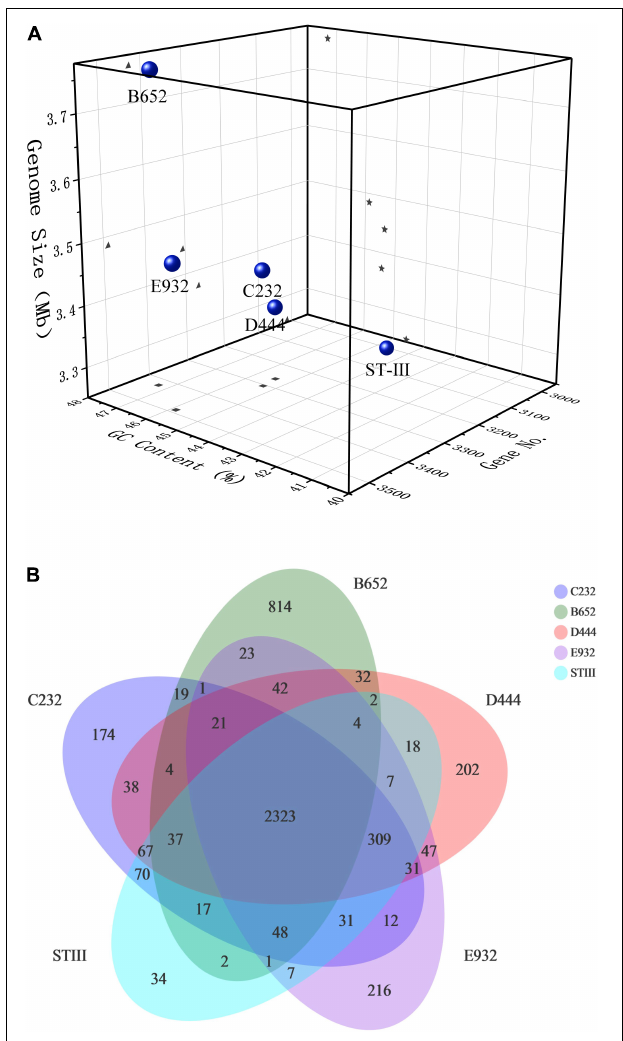
FIGURE 3 | Genomic analysis of the selected L. plantarum strains: (A) basic genomic features; (B) common and unique genes distribution. In the Venn diagram (B) , the number in the center shows the common genes shared by contained all strains and the outermost edge show the number of unique genes for each